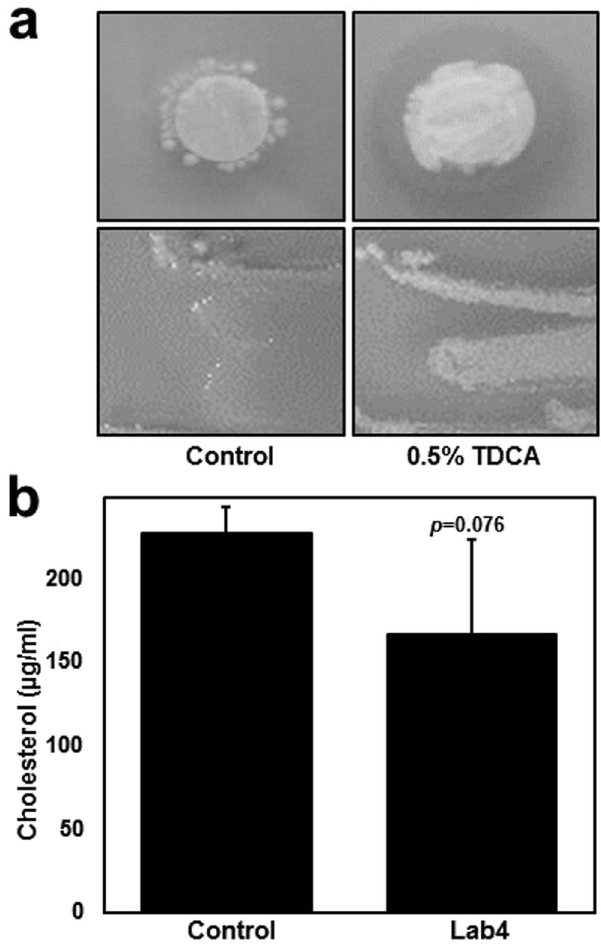
Figure 1. BSH activity and cholesterol assimilation by Lab4. ( a ) De Man, Rogosa and Sharpe (MRS) agar plates (control, top and bottom left-sided panels) or MRS agar plates containing 0.05% taurodeoxycholic acid (TDCA, top and bottom right-sided panels) that were inoculated with Lab4 on filter discs (top panels) or as bacterial streaks (bottom panels, n = 1) for 48 hours under anaerobic conditions. ( b ) Cholesterol concentration in MRS broth containing 0.3% (w/v) ox-bile and 200 µ g/ml cholesterol (control) or in MRS broth containing 0.3% (w/v) ox-bile and 200 µ g/ml cholesterol that were inoculated with Lab4 for 18 hours under anaerobic conditions. The data are presented as a representative image from 3 identical experiments (unless stated, Fig. 1a) or the mean ± SD from three independent experiments (Fig. 1b). Statistical analysis was performed using Student’s t - test and values of p are stated where